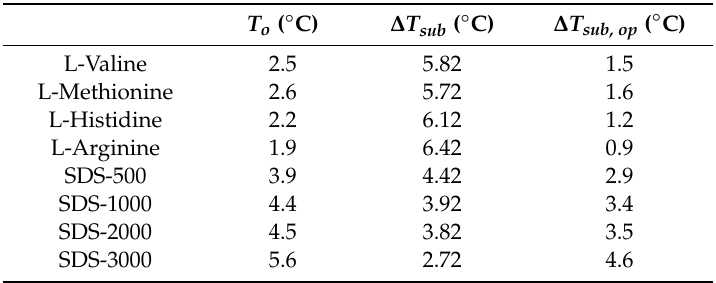
Table 1. Variation in nucleation temperature (T o ) and subcooling ( ∆ T sub ) in the presence of Sand B and Gas B in the presence of di ff erent chemicals. Amino acid concentration is 3000 ppm. SDS is denoted with a number representing the concentration in ppm.